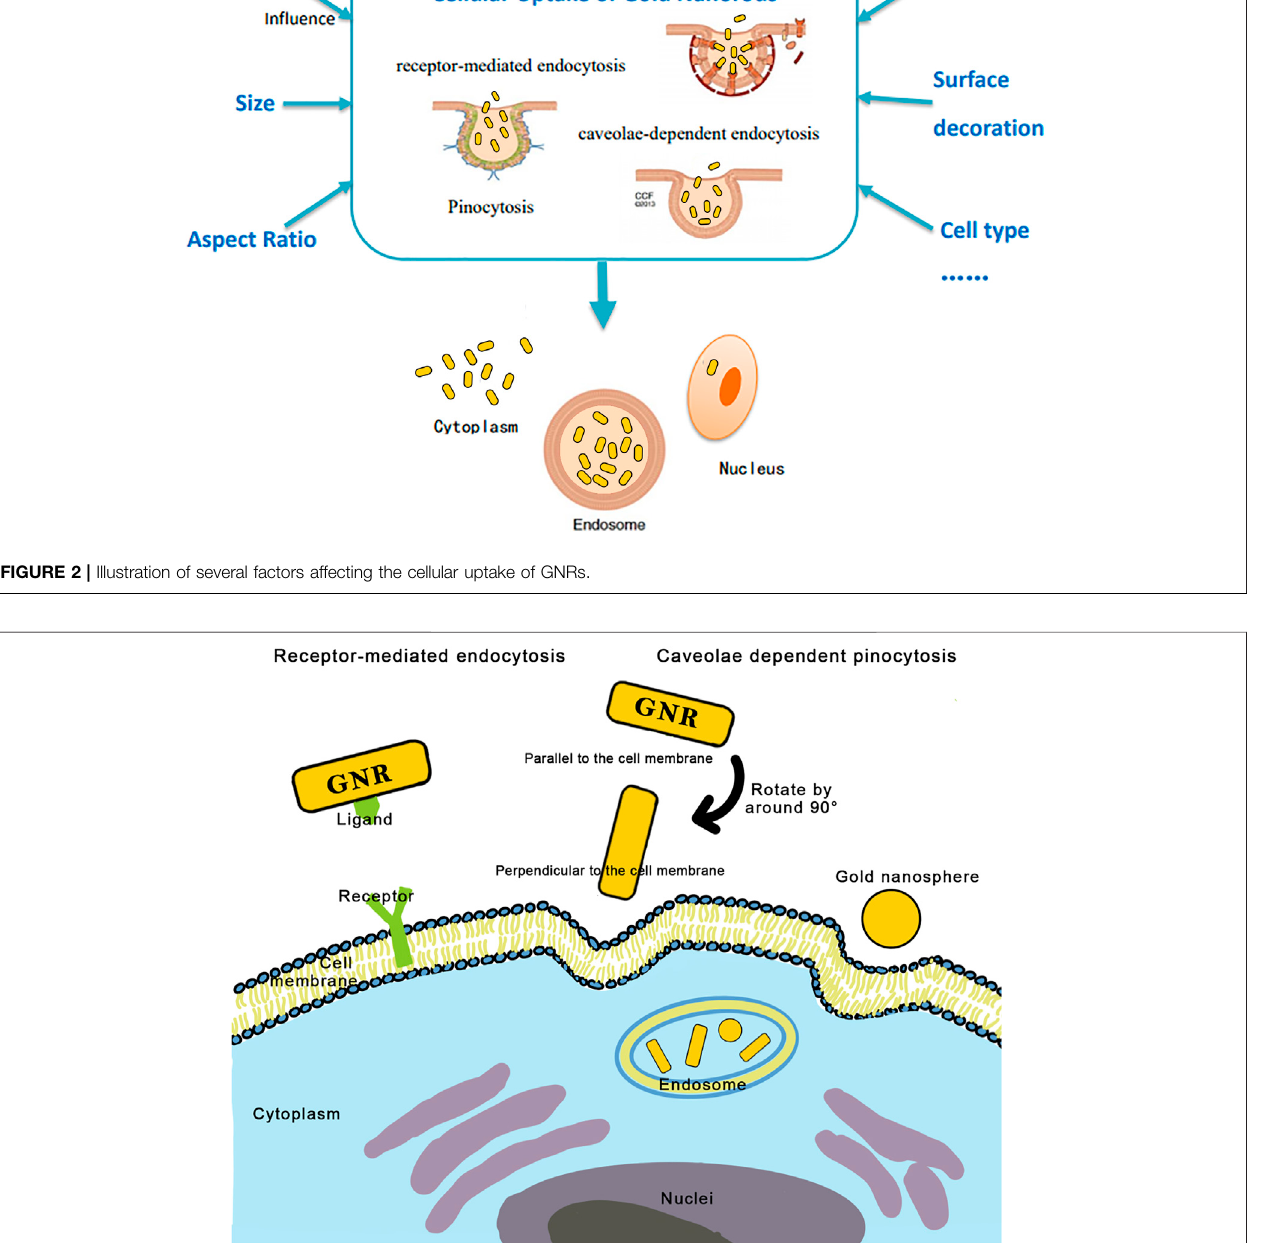
Frontiers in Pharmacology |